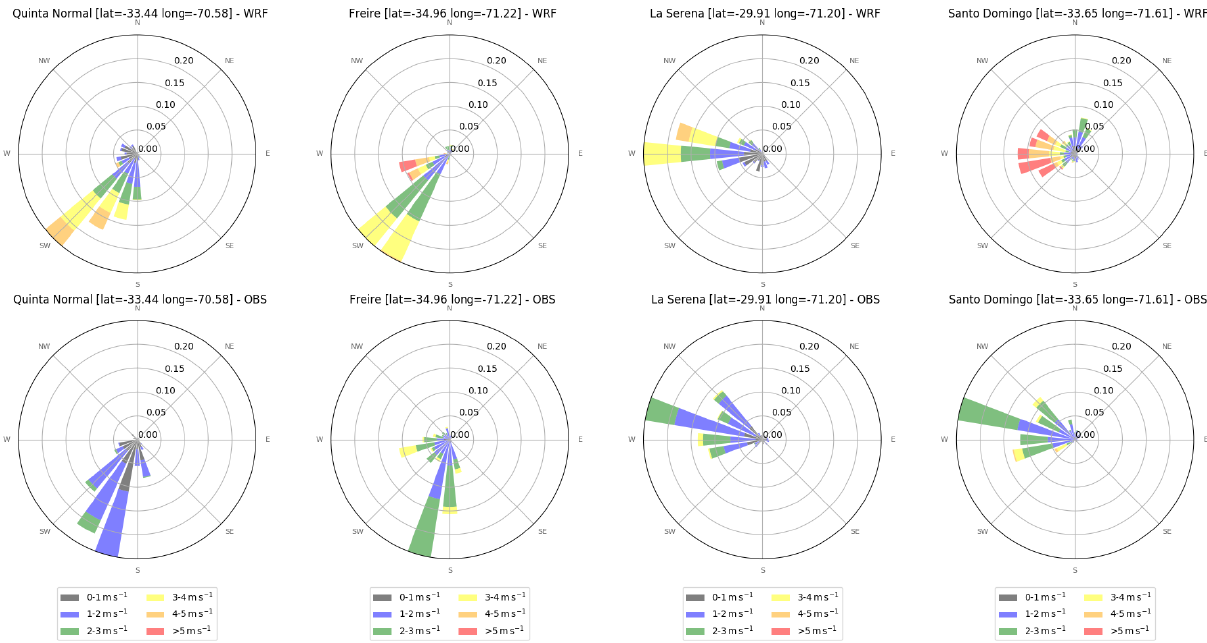
Figure A2. The 10m wind distribution in the simulation (top) and observations (bottom) at four locations in central Chile for summertime in 2015.